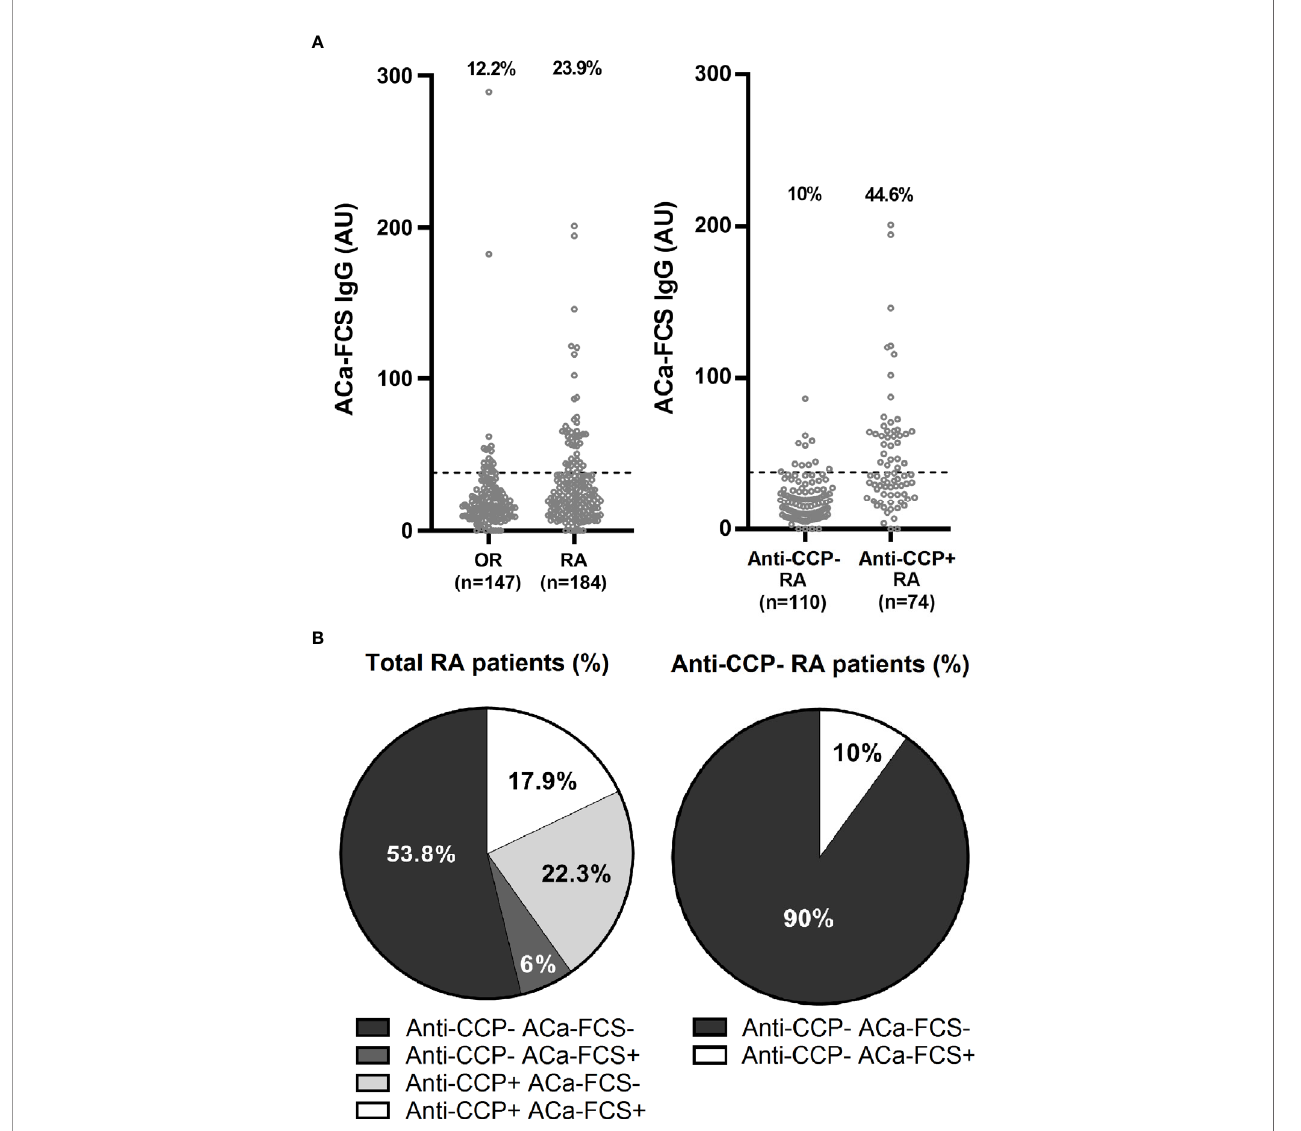
FIGURE 1 | Titer, prevalence, and distribution of ACa-FCS and anti-CCP antibodies in the VErA cohort at baseline. (A) ELISA test for detection of ACa-Fib IgG based on RA status (n=184) and other rheumatism (OR) (n=147) and anti-CCP antibodies status in RA patients (n=184). (B) Distribution of anti-CCP antibodies and ACa-FCS in RA patients from the VErA cohort. Anti-CCP, anti-cyclic citrullinated peptide antibodies; ACa-FCS, anti-carbamylated fetal calf serum